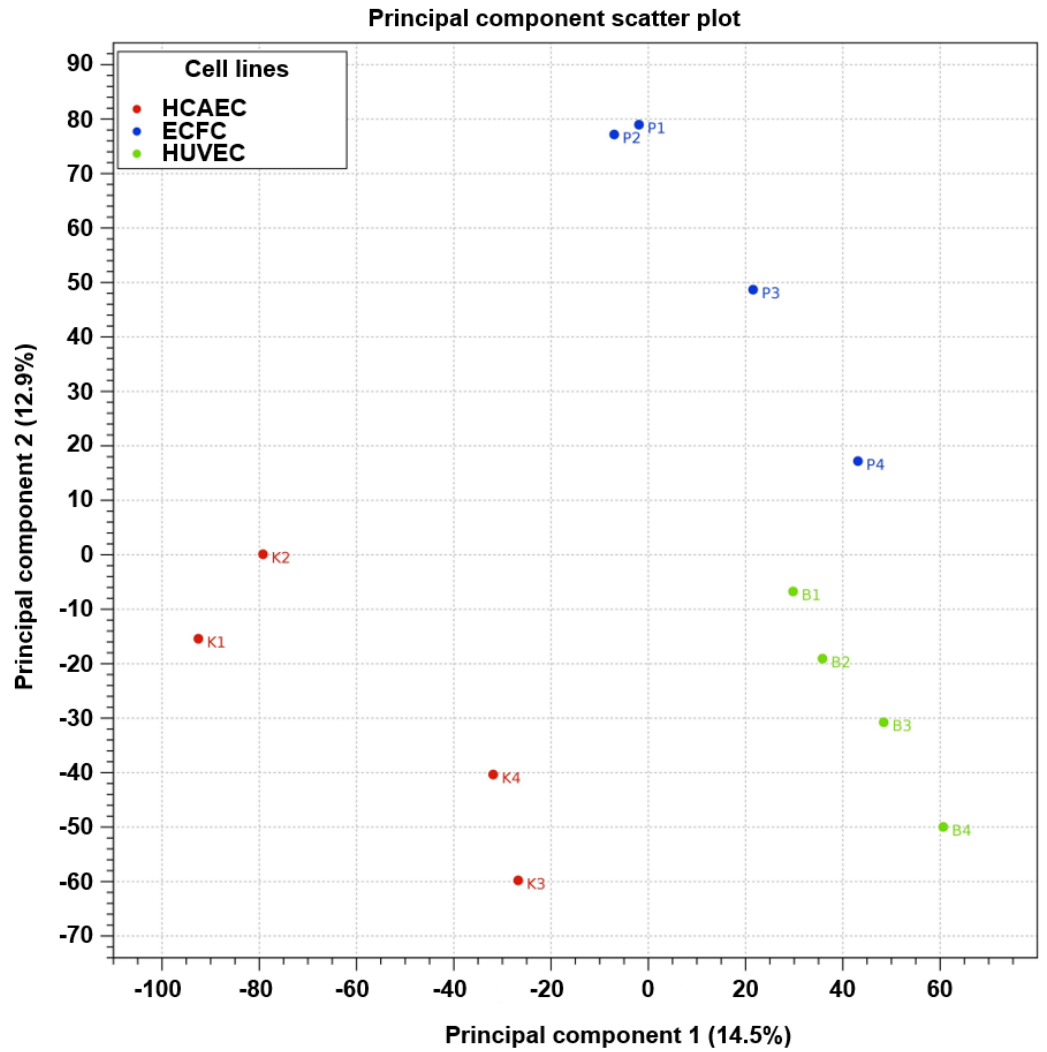
Figure 7. 2D sample clustering based on a principal component analysis (PCA) of differentially expressed genes (DEGs). The red, blue, and green dots indicate HCAEC, ECFC, and HUVEC samples, respectively. Principal components are defined along the X and Y axes as component 1 and component 2, respectively; the proportion of explained data variance is indicated in brackets for each principal component.